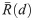
Power performance of statistics related to R¯(d), R˜(d), and C(d) under alternative hypothesis (1) with parameter μo = 375.Only maximum powers of R¯(d), R˜(d), and C(d) over values of d considered are displayed; dmax refers to the value of d yielding the largest power.